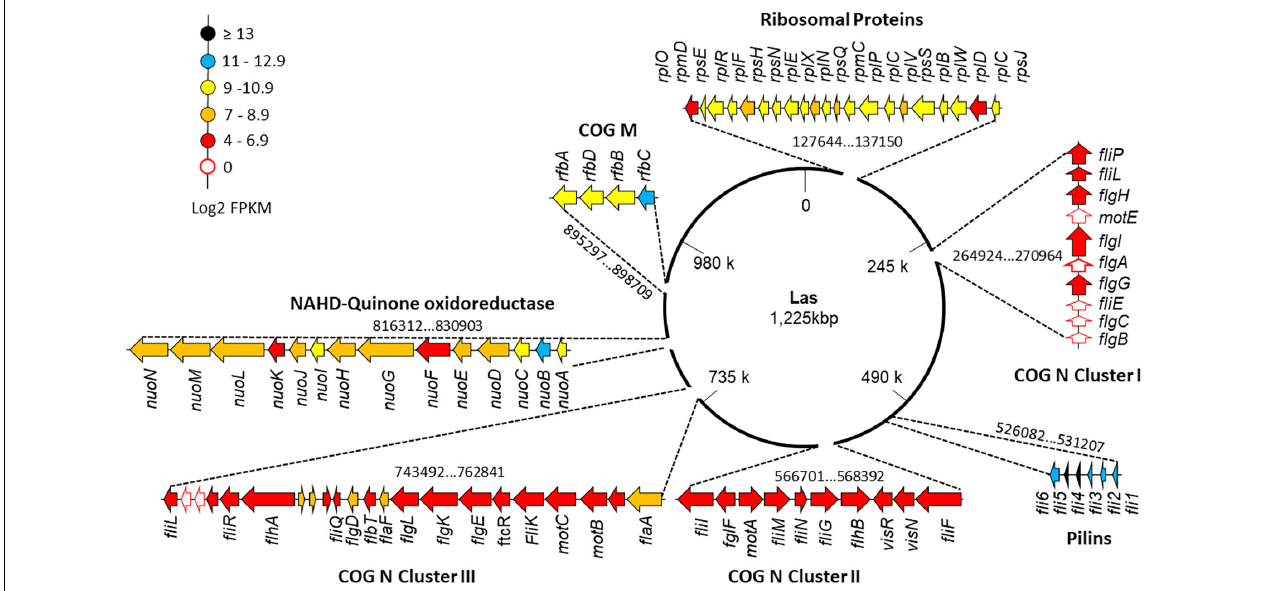
FIGURE 4 | Gene expression level along “ Candidatus Liberibacter asiaticus” chromosome of selected clusters of genes. Flagellar clusters (COG N: Clusters I, II, and III), “Flp family type IVb pilins” (COG U), transferases (COG M), ribosomal proteins, and NADH-quinones genes are individually shown and their position in the chromosome is indicated. Read abundance (log2FPKM) taken from Diaphorina citri gut library from the acquisition time 5/6 days (Las III) mapped in strain JXGC